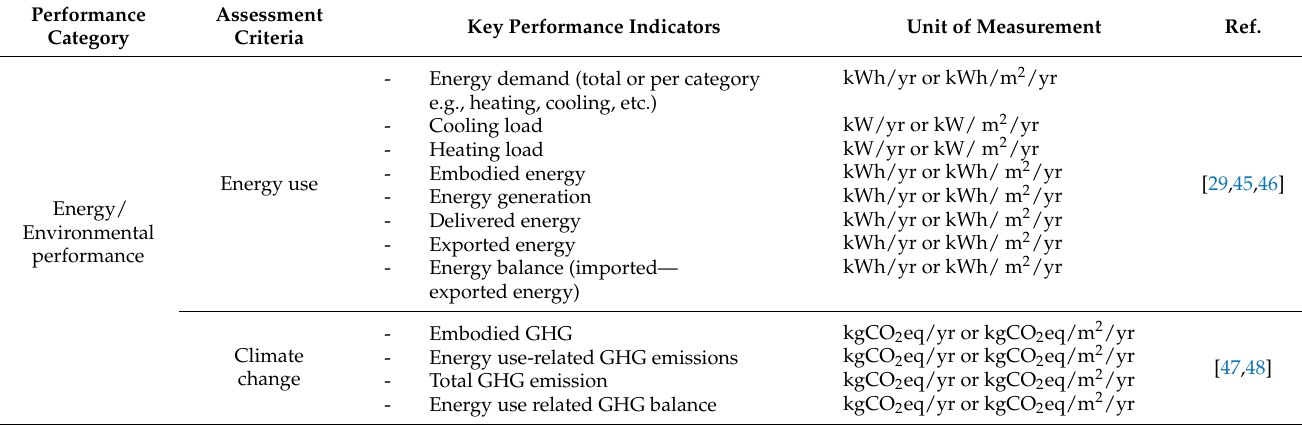
Table 1. Performance criteria and indicators for RBE assessment in